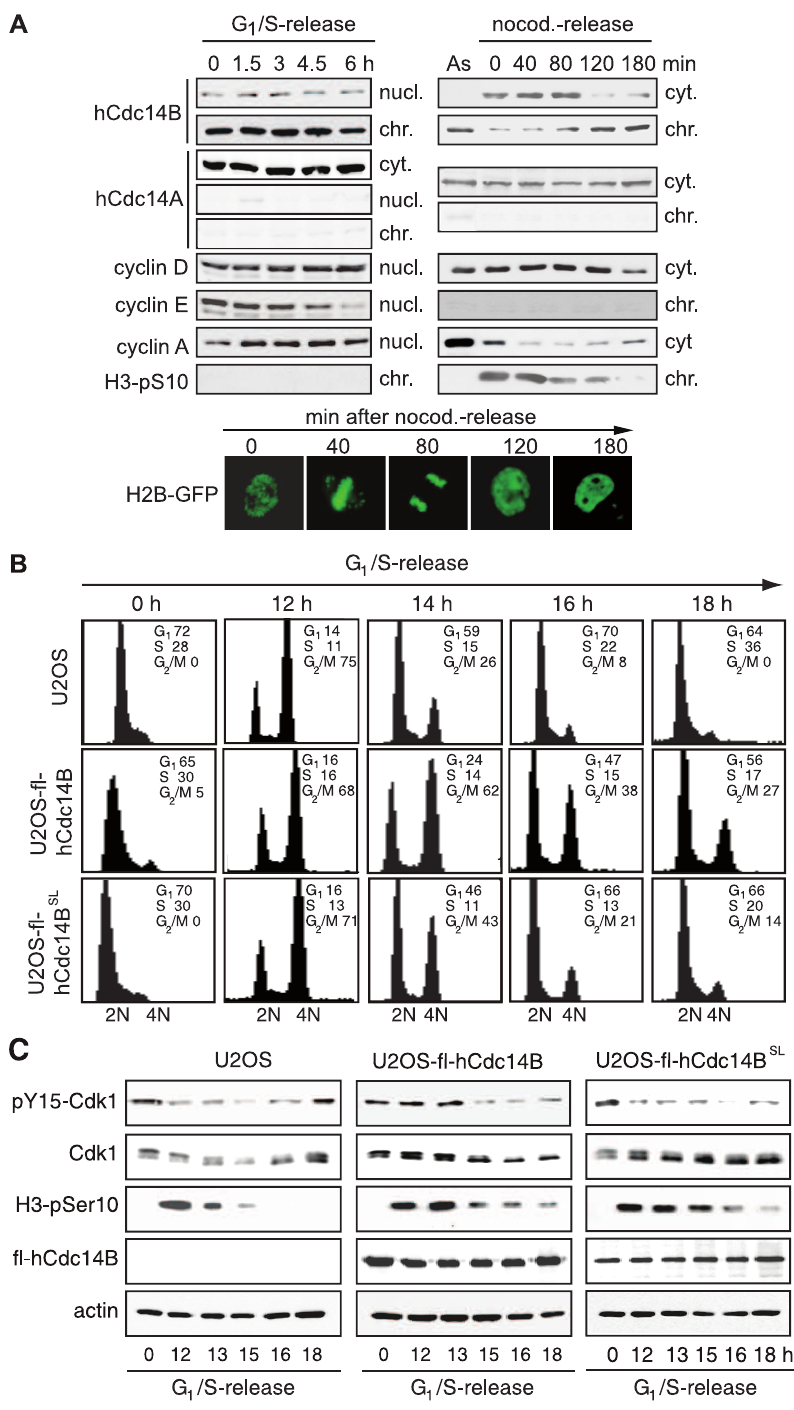
Figure 1. Overexpression of hCdc14B alters progression through mitosis. A . hCdc14B is released from chromatin in early mitosis and is rebound in late M/early G 1 . HeLa cells expressing histone H2B-GFP (HeLa Kyoto) were arrested at G 1 /S by double thymidine-block (left) or at prometaphase of mitosis by nocodazole (right), and released for the indicated times. Release from nocodazole (nocod.) arrest was monitored visualizing H2B-GFP labelled chromatin (bottom panel). Synchronized cells were fractionated into cytoplasm (cyt.), nucleoplasm (nucl.) and chromatin (chr.), and analyzed on immunoblots for the proteins indicated (top panels). B . Overexpression of hCdc14B prolongs G 2 /M-phase. FACS of U2OS, U2OS-fl-hCdc14B and U2OS-fl-hCdc14B SL cells following release from G 1 /S (0 h) upon induction of hCdc14B expression by doxycyclin (Fig. S1). Cell numbers were calculated using the Cell Quest software program. The percentage of cells at the indicated cell cycle phases is presented. C . Overexpression of hCdc14B affects mitotic progression. Immunoblots showing the abundance of specific cell cycle marker proteins at distinct time points (h) after release from G 1 /S.